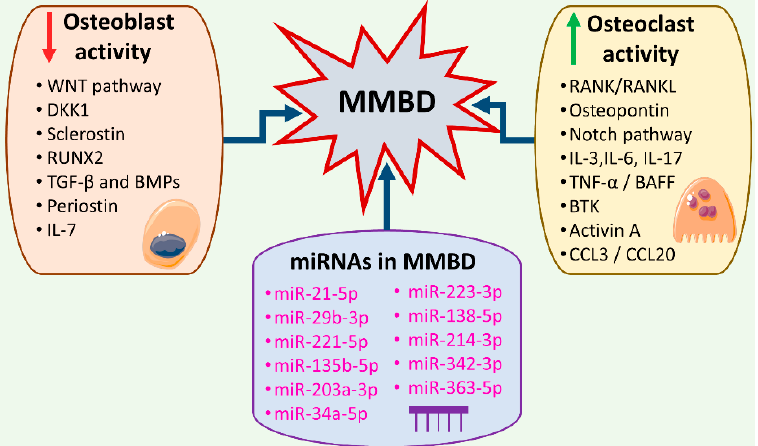
Figure 1. A brief description of the molecular background of multiple myeloma bone disease (MMBD), showing molecules and pathways affecting osteoblast and osteoclast activity, as well as the main microRNAs (miRNAs) playing a role in MMBD.